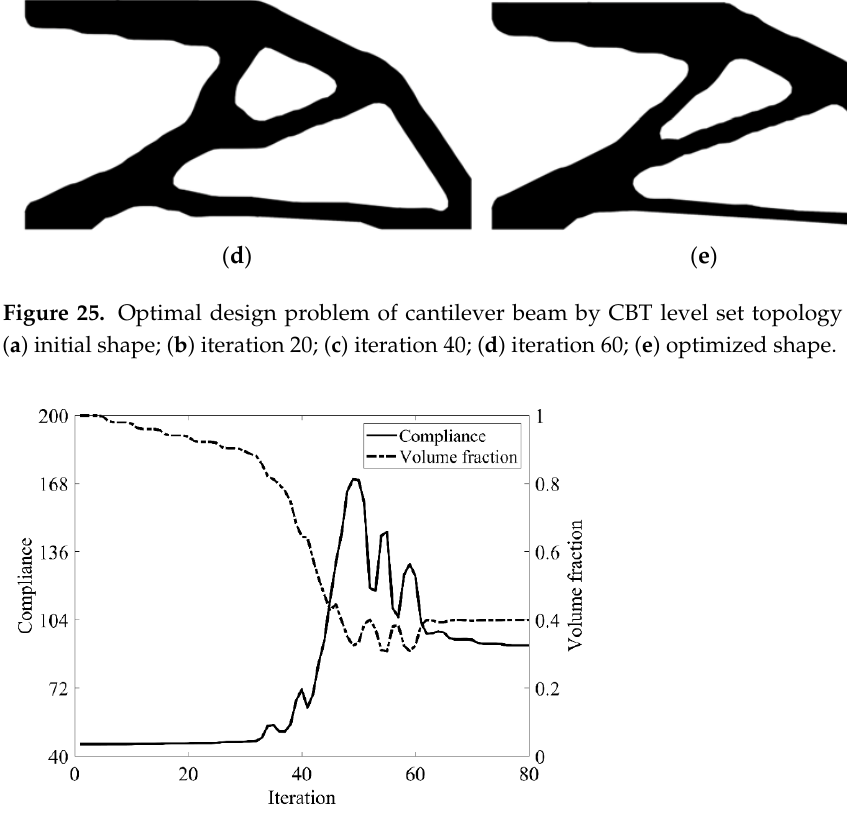
Table 4. Results for topology optimization of cantilever beam.